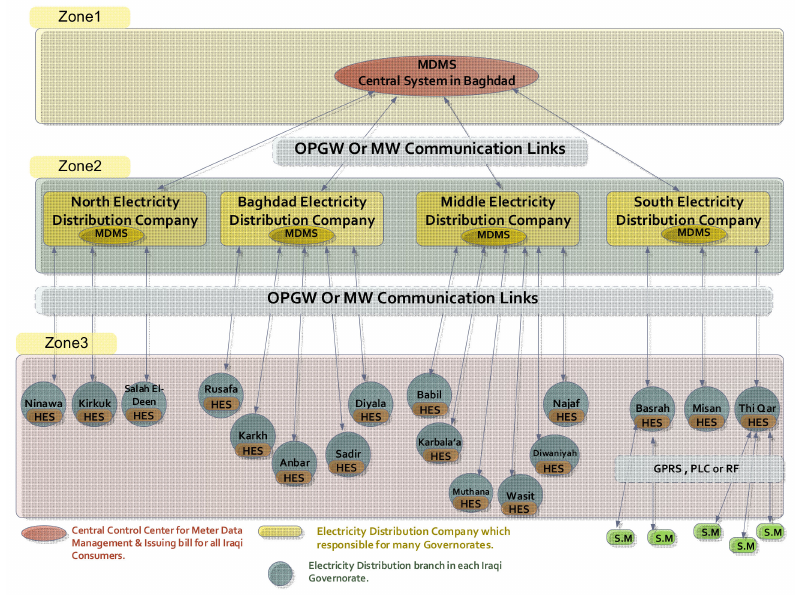
Figure 3. Proposal 1 of Iraqi Ministry of Electricity (MOELC) smart grids advanced metering infrastructure (SG-AMI) architecture.